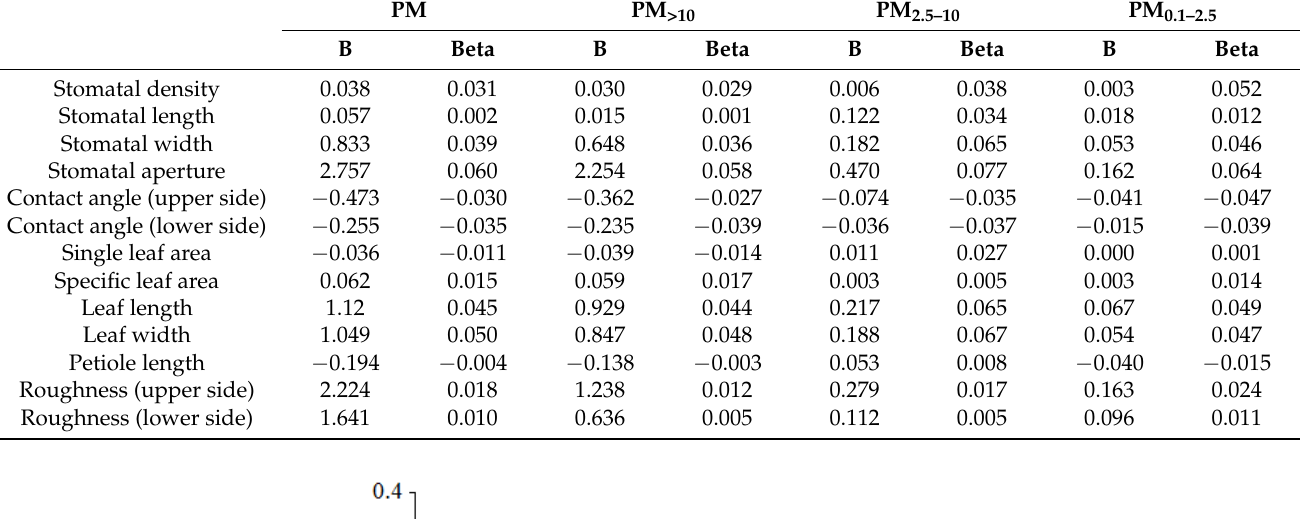
Table 3. Regression coefficient (B) and standardized regression coefficient (Beta) of the partial least squares regression model for the factors affecting leaf particulate matter capturing of four tree species. PM PM >10